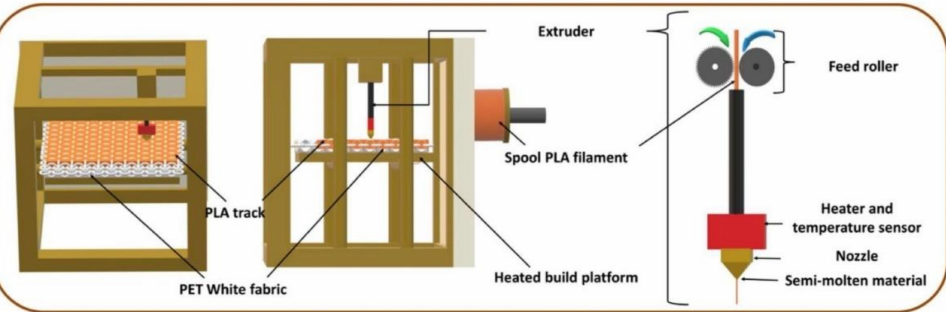
Figure 24. Fused deposition modeling process onto textiles (Reproduced with permission from Reference [179], copyright 2020,